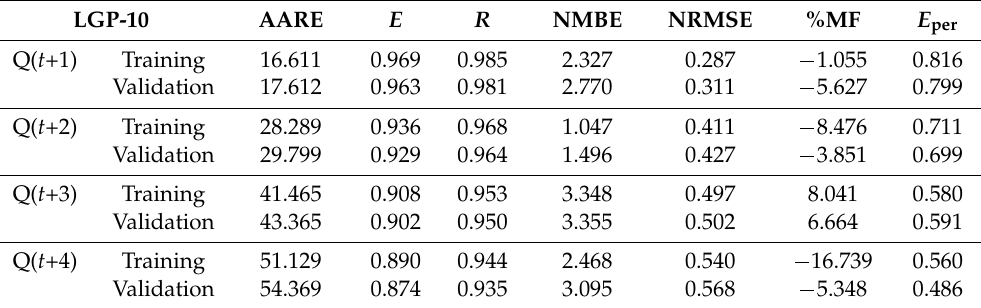
Table 9. Statistical parameters for